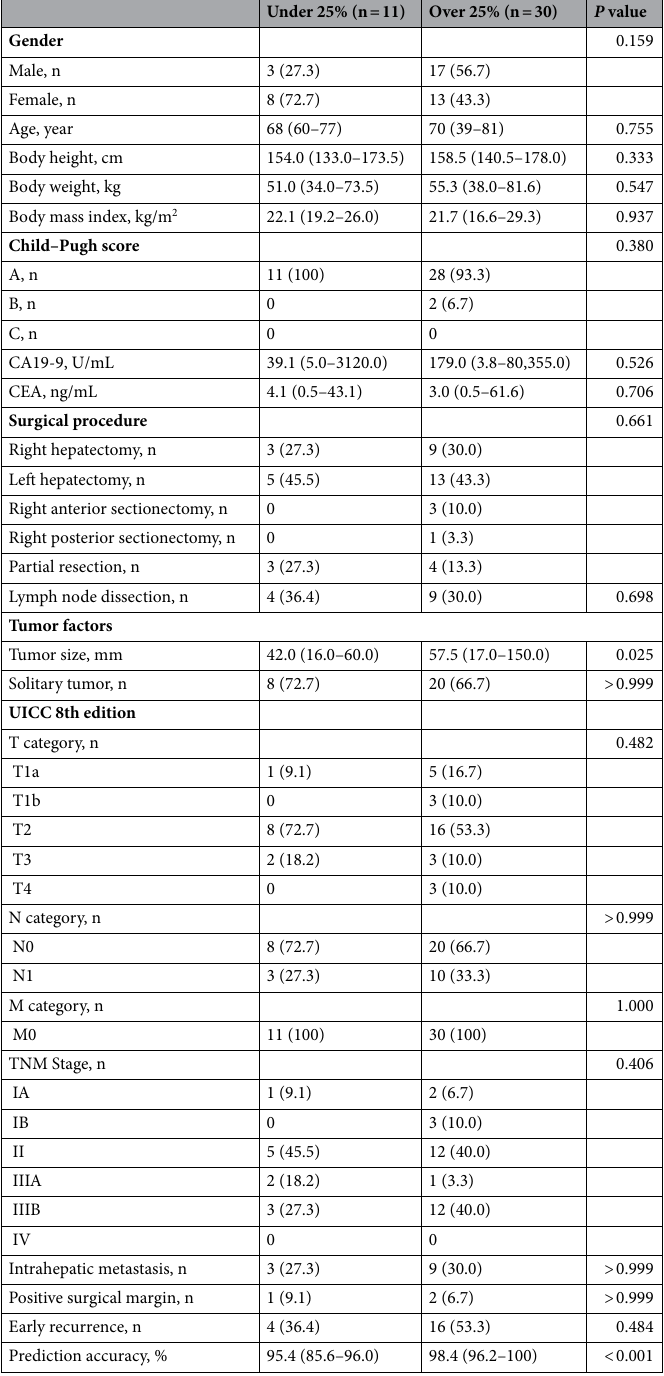
Table 4. Comparison of perioperative characteristics depending on prediction accuracy. CA19-9 carbohydrate antigen 19-9, CEA carcinoembryonic antigen, UICC union for international cancer